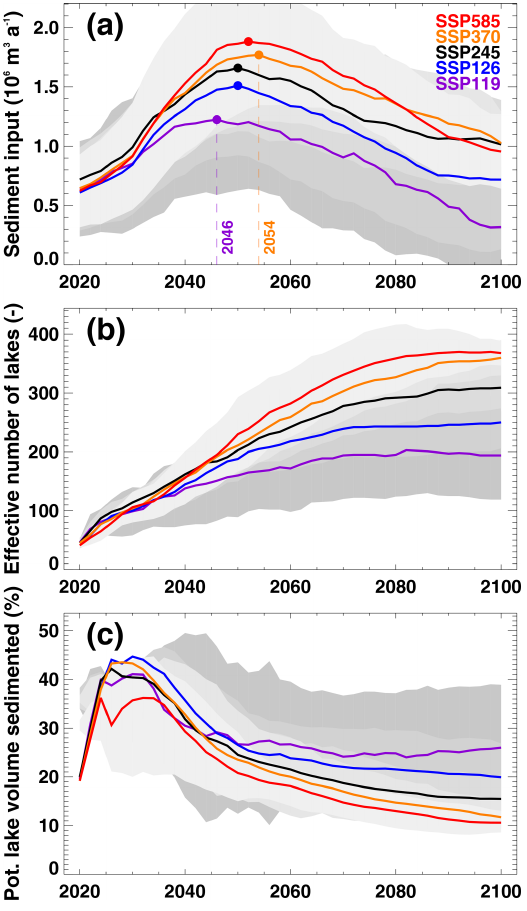
Figure 4. (a) Temporal evolution of modelled annual sediment input into new potential lakes formed due to glacier retreat after 2016 (onset of glacier evolution modelling) for all SSPs. Lines are smoothed with a 11-year running mean and represent the average of all 13 GCMs for a given SSP. Dots indicate the timing of the maximum sediment input into lakes. (b) Evolution of the effective number of new potential lakes, i.e. accounting for lake basins being completely filled with sediment. (c) Share of potentially available lake volume throughout the 21st century being sedimented for the respective scenario. In all panels, the grey bands denote the variabil- ity stemming from the individual climate models contained within a given